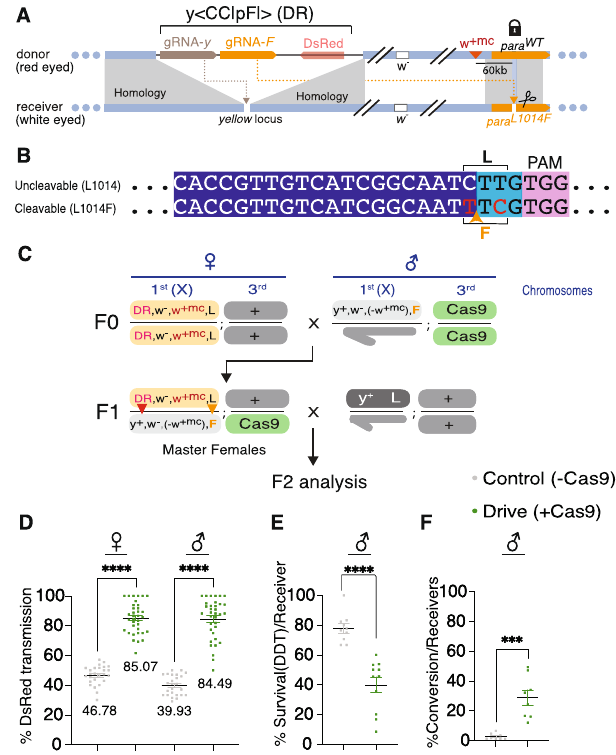
Fig. 2 Conversion of the insecticide resistant para L1014F allele to para WT . A y <CC|pF|> allelic-drive element carrying a DsRed marker and two gRNAs: (1) gRNA- y (brown), which sustains copying of the drive element; and (2) gRNA -F (orange), which targets the insecticide resistant, gRNA-sensitive para L1014F allele (scissors icon) to drive super-Mendelian inheritance of the insecticide-susceptible, uncleavable para WT allele (lock icon) when Cas9 is provided in trans. In addition, a mini-white marker ( w + mc , red triangle ), about 0.5 cM from para L1014 is used to track the donor chromosome carrying the para WT allele. B gRNA sequence targeting para L1014F and its cut-sensitive TTC codon (coding for phenylalanine = F), and the uncleavable CTT para WT allele (coding for Leucine = L, marked in red). The cut site is indicated with an arrowhead. C Crossing-scheme used to generate F1 “ master females ” . The yellow shaded X donor chromosome carries the DsRed-marked drive element ( y <CC|pF|> ) and the para WT allele (labeled L) associated with a white + insertion ( + w + mc ), which dominantly confers red eye color in the white − mutant background. The receiver white − X chromosome, which carries the cut-sensitive para L1014F allele, but lacks the w + mc insertion ( − w + mc in C ), is followed through the white − eye color phenotype. A GFP- marked transgene expressing Cas9 ( vasaCas9 ) on the third chromosome is depicted in green and wild-type ( + ) chromosomes in light gray. Red and orange arrowheads indicate copying of the drive element and the para WT allele, respectively. D Percent transmission of the drive in the presence (DR, green circles) or absence (gray circles) of Cas9 in females and males. Values indicate mean (±s.e.m) percent transmission for each genotype. Data analyzed using one-way ANOVA followed by Sidak ’ s multiple comparison tests. Chi-square test for DsRed proportions was also performed in presence and absence of Cas9. p < 0.0001 was seen in both females and males. E Percent survival to 50 ppm DDT in male receiver populations in the presence (green circles) or absence (gray circles) of Cas9. F Percentage conversion at 1014F locus for receiver chromosomes (selected for w − eye phenotype) was determined based on the proportion of individual F2 male progeny that carried one or the other allele by sequencing of PCR ampli fi ed DNA. These F2 males were collected from F1 master females ( y <CC|pF|> drive, w + mc , para WT / para L1014F ; Cas9/ + ♀ X w − ♂ ). E , F Means ± s.e.m are plotted. Data were analyzed by Mann – Whitney test . * p < 0.033, ** p < 0.0021, *** p < 0.0002, **** p < 0.0001, ns not signi fi